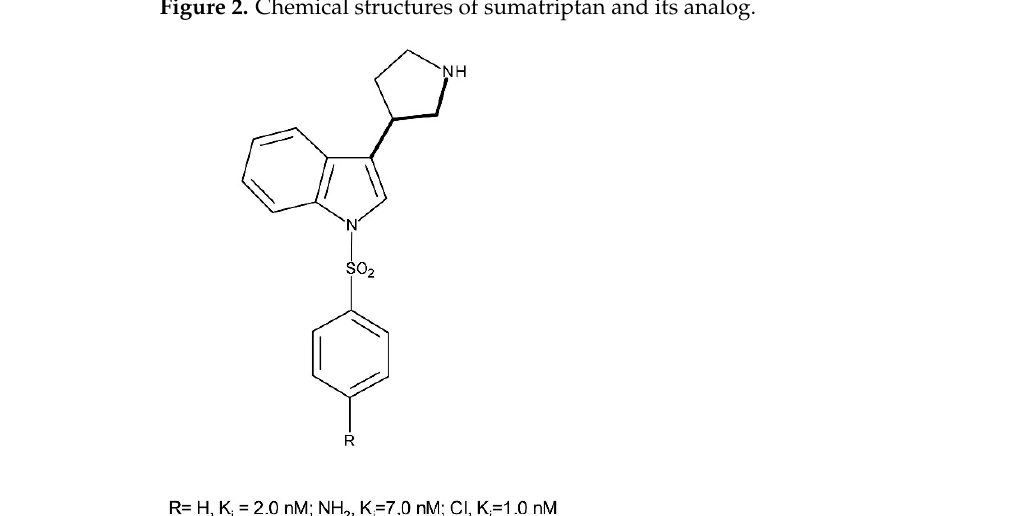
Figure 2. Chemical structures of sumatriptan and its analog.